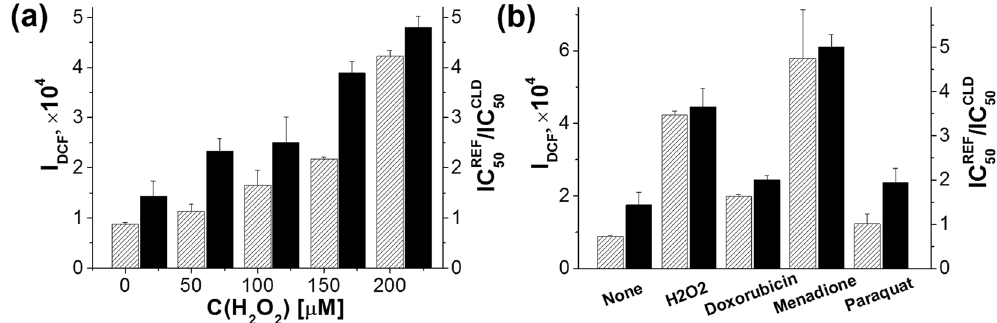
Figure 8. Correlation between CLD cytotoxicity and the level of oxidative stress. Effect of hydrogen peroxide ( a ) and other oxidative stress inducers ( b ) on DCF fluorescence intensity normalized to mg of cellular protein (shaded bars) and on the PS-mediated cytotoxicity of CLD expressed as IC IC / REF CLD